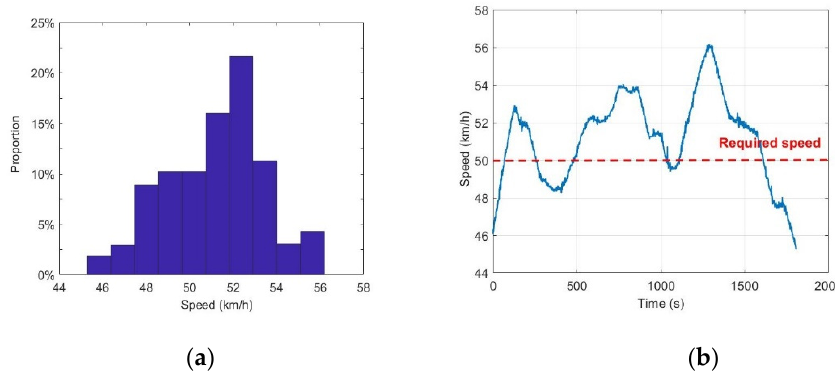
Figure 7. ( a ) The distribution of speed and ( b ) the speed curve of subject 1 on a straight lane; the required speed is 50 km/h.